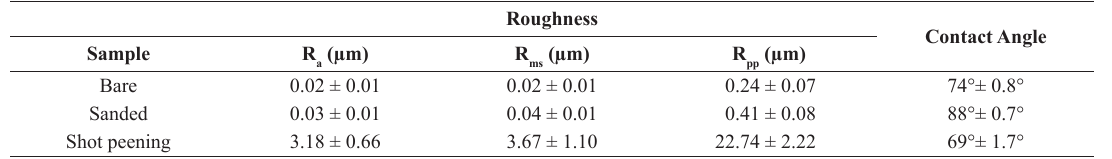
Figure 2. Images of the surface topography obtained by profilometry for the samples: (a) Bare, (b) Sanded and (c) Shot Table 2. Results of profilometry and wettability of the samples.